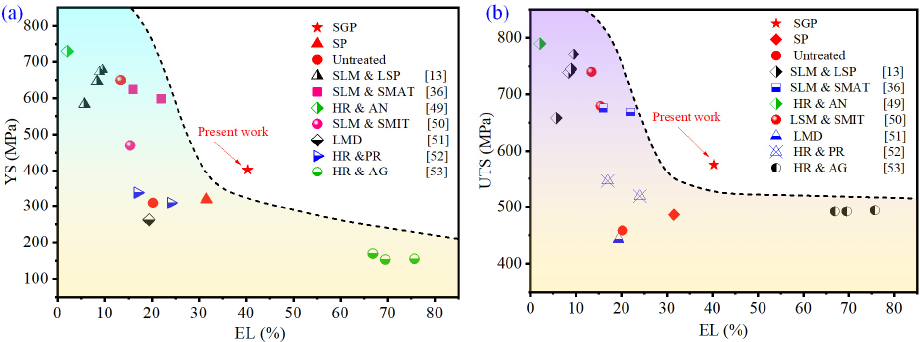
Figure 11. The comparison of the results from the current study and 316L steel modified by different strengthening methods [13,36,49–53]. ( a ) the comparison of YS; ( b ) the comparison of UTS. Table 4. Processing and tensile properties of 316 L stainless steel obtained from previous works and present work.